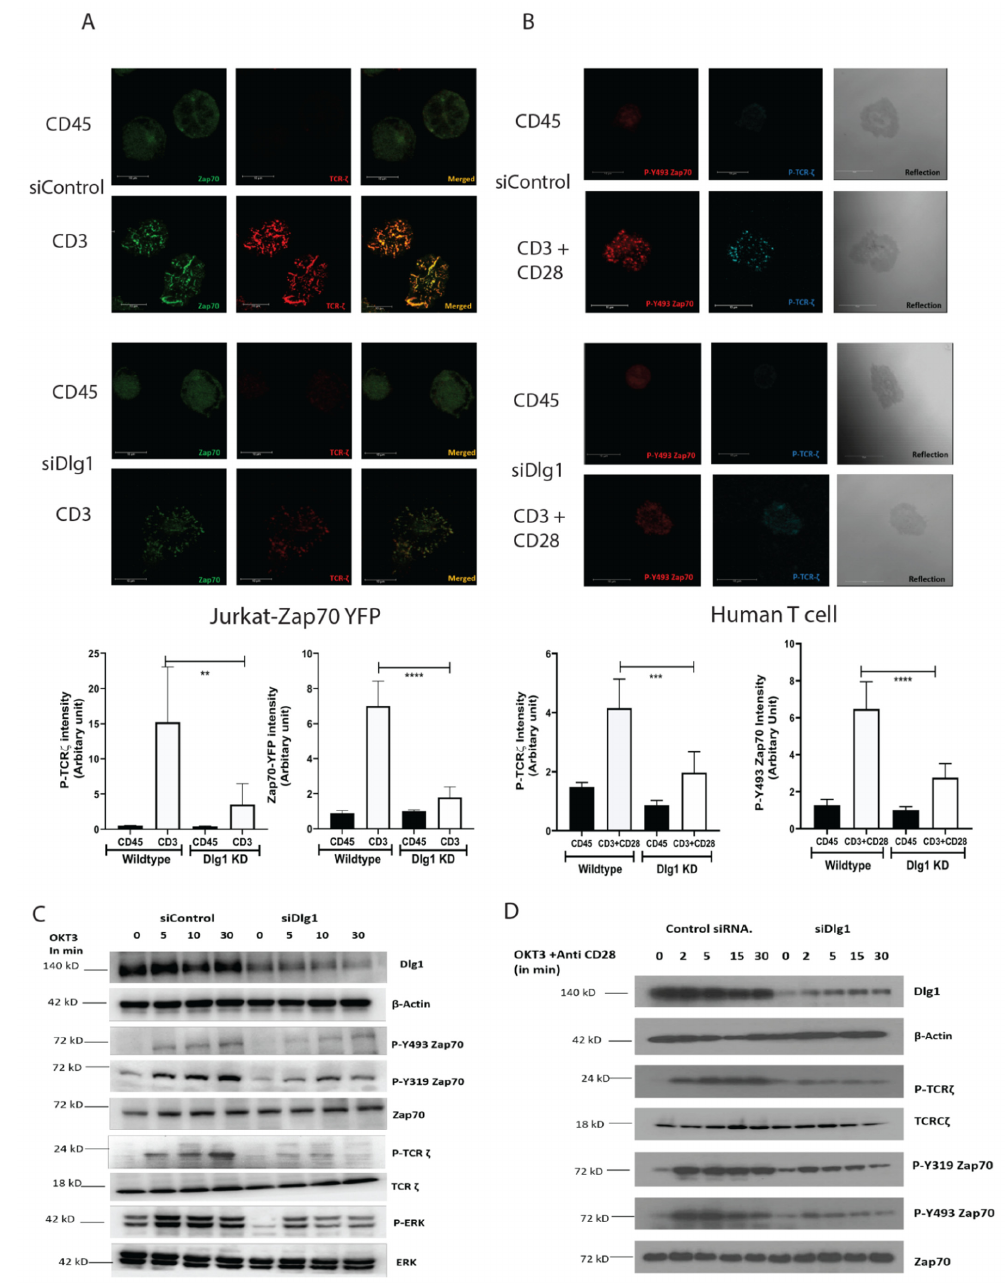
Figure 1. DLG1 knockdown inhibits TCR-MC formation and subsequent proximal signaling. ( A , B ). Microcluster analysis. Scale bars, 10 µ m. ( A ) Jurkat cell analysis. Microclusters of ZAP-70–YFP (green) and phosphorylated TCR- ζ (red) were visualized in immunostained Jurkat cells stably expressing ZAP-70–YFP, pretreated with control or DLG1-specific siRNA. Cells were dropped onto coverslips coated with anti-CD3 (stimulated) or anti-CD45 (unstimulated) and visualized after 5 min. Quantitative data for specific signals’ intensities (using Image J; collected from eight fields) are graphically represented. ( B ) Primary human CD4 + T cells. Microclusters of phosphorylated Y493 ZAP-70 (green) and phosphorylated TCR- ζ (red) were visualized in immunostained human T cells, pretreated with control or DLG1-specific siRNA. Cells were dropped onto coverslips coated with anti-CD3+anti-CD28 (stimulated) or anti-CD45 (unstimulated) and visualized after 5 min. Quantitative data for specific signals’ intensities (using Image J; collected from eight fields) are graphically represented. ( C , D ). Immunoblot analysis of lysates from Jurkat cells ( C ) and human T cells ( D ) pretreated with control or DLG1-specific siRNA and then activated with soluble anti-CD3 (monoclonal antibody OKT3) and antibody to mouse immunoglobulin G (IgG), followed by probing for phosphorylated and total proteins. Data are representative of three experiments. Student’s unpaired t tests were used for ( A , B ). ** p < 0.01, *** p < 0.001, **** p <